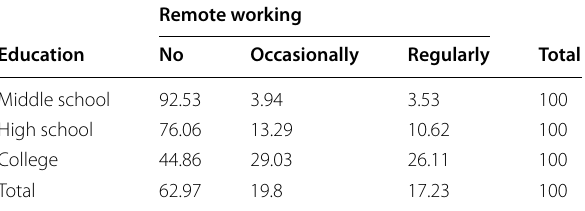
Table 15 Telework availability and educational level Table 16 Telework availability by gender